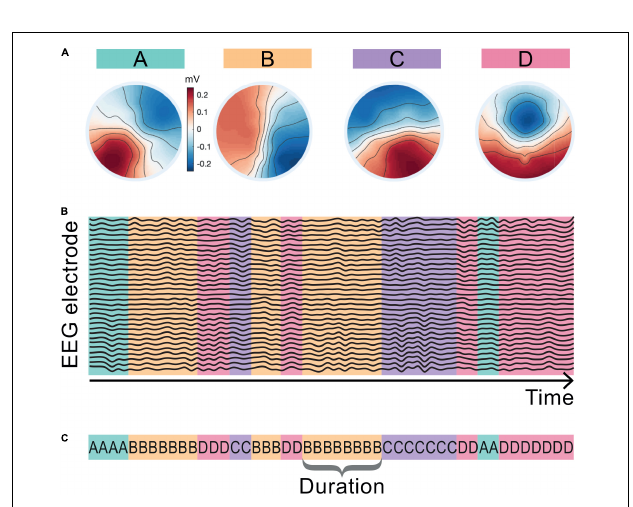
FIGURE 2 | Microstate maps and back-fitting. The four EEG microstate topographies resulting from the microstate segmentation of the whole cohort including the baseline and LKM-S epochs are shown in panel (A) . Maps are aligned and labeled A–D in line with the four canonical microstate maps in the literature. Schematic in panel (B) shows assigned map that best fits the EEG topography at each sampling point of the EEG data. Panel (C) shows the corresponding microstate sequence and the definition of microstate